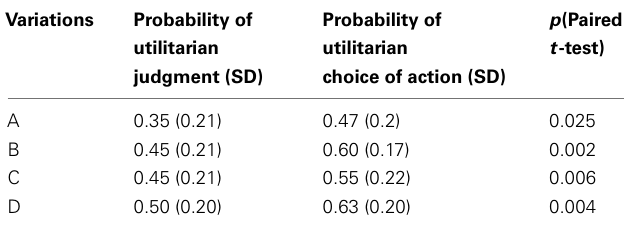
Table 2 | Probability of utilitarian judgment when varying affective